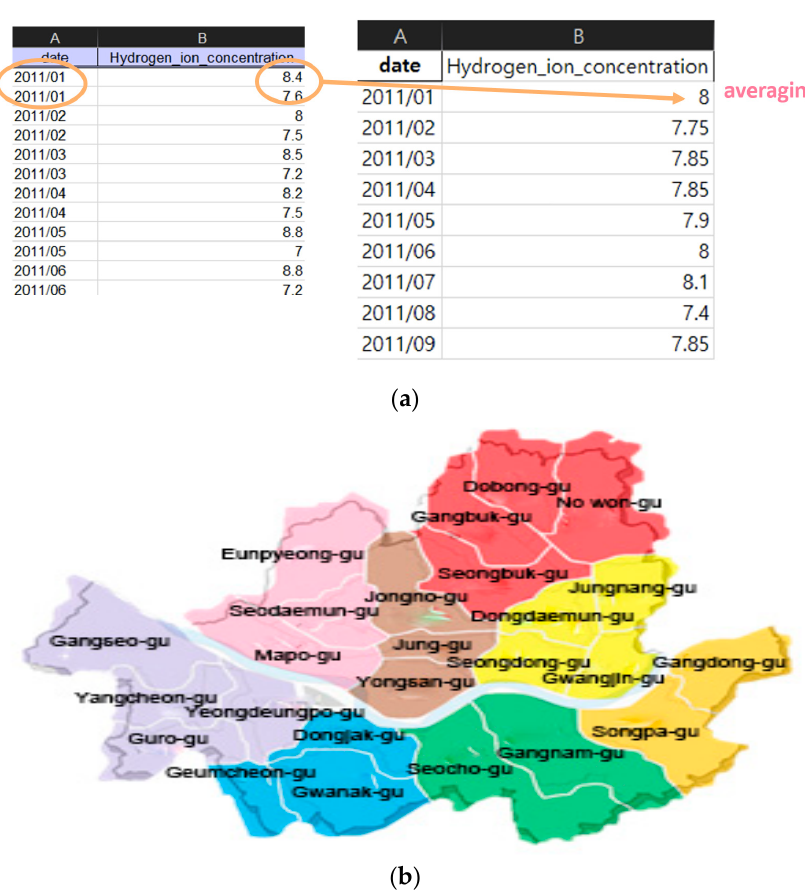
Figure 4. Regulation of data ( a ) left: original data, upper right: mean of monthly data, ( b ) integrated living area.